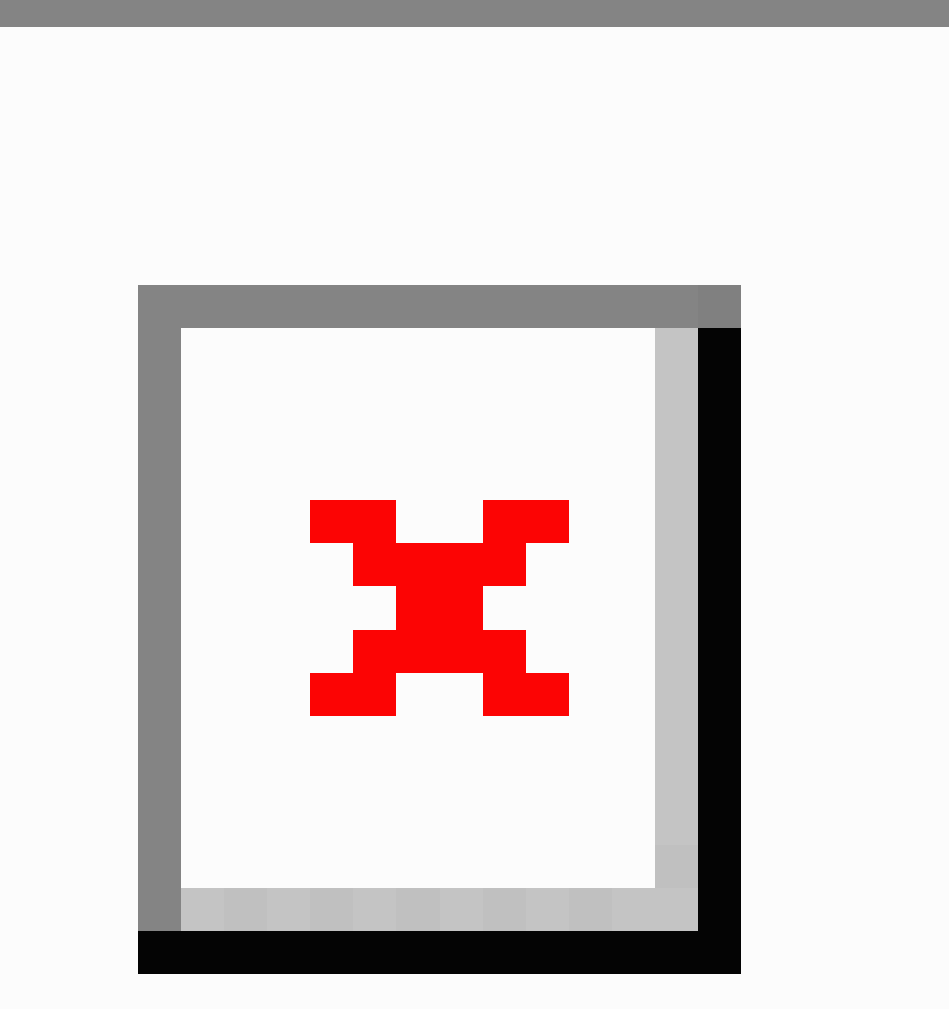
Figure 2. Weekly ratings of depressive symptoms (MADRS-S, maximum score is 54 points), symptoms of (hypo)mania (AS-18, maximum score for mania section is 36), and insomnia (ISI, maximum score is 28 points) for patient 1. The vertical line marks the start of the intervention period. Dashed blue lines indicate the mean level of depressive symptoms (MADRS-S) during the baseline period and the treatment